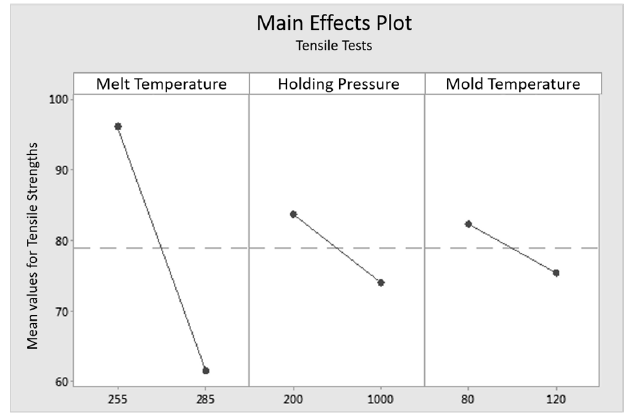
Figure 14. Main effects plot of tensile tests for the influencing factors “mass temperature”, “holding pressure” and “mold temperature” on the tensile load in the fiber orientation.